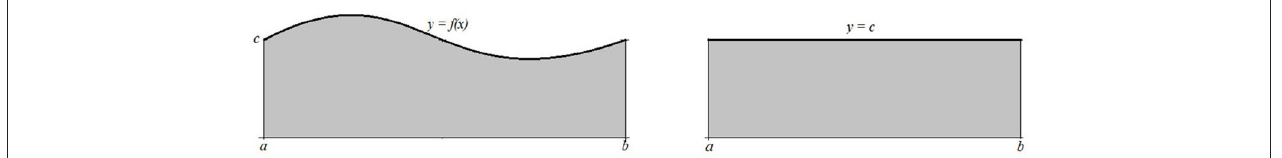
FIGURE 9 | Integral computation.